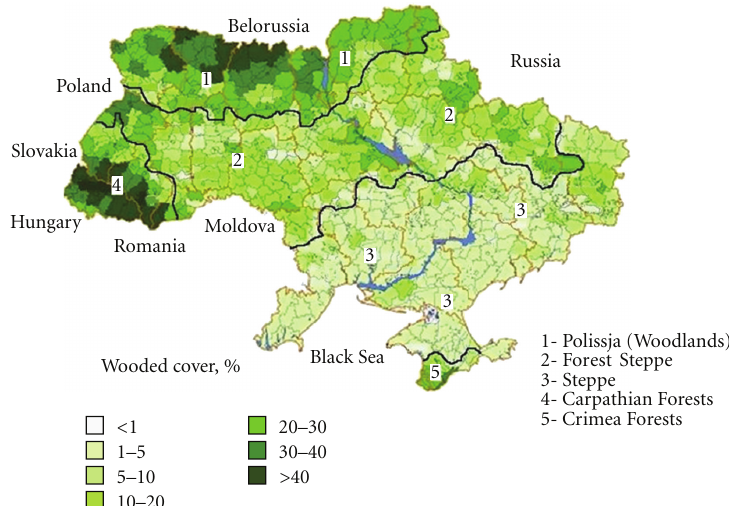
Figure 1: Forestry zoning of Ukraine Source: adapted from [39] and the records of the National Academy of Sciences [47].